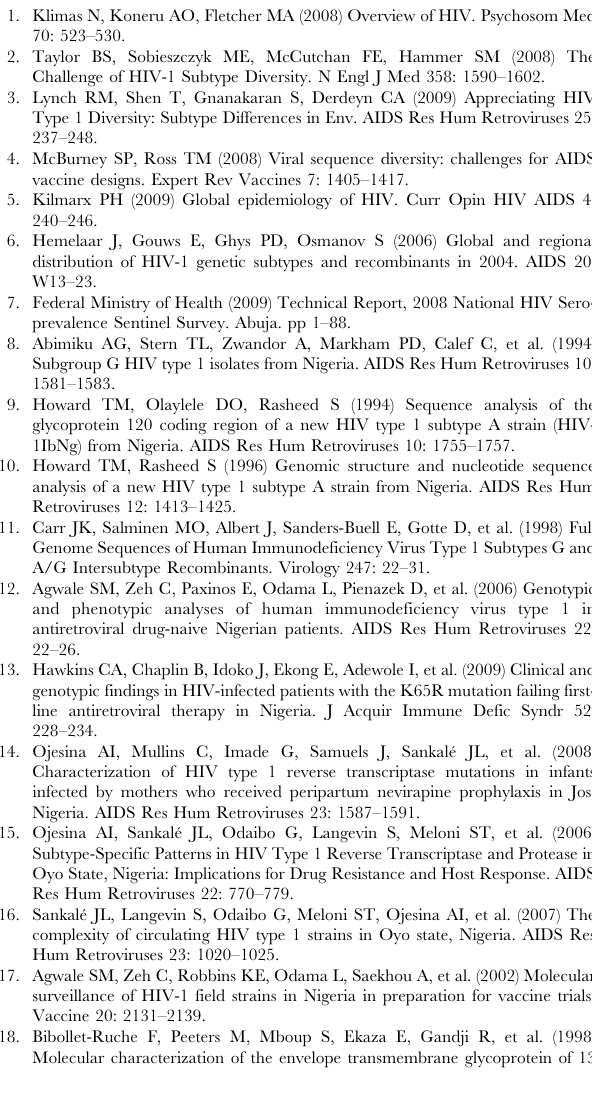
Table S1 Accession number of sequences downloaded from the HIV Los Alamos Database.